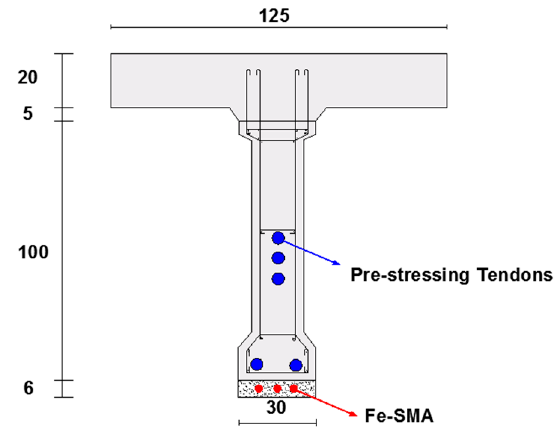
Figure 27. Longitudinal profile and cross-section of the girders (in cm) [33].